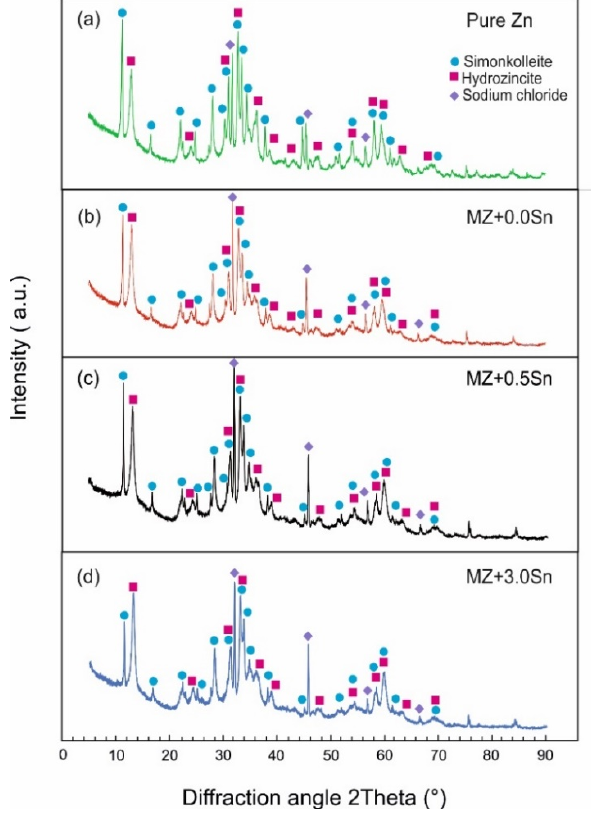
Figure 11. XRD patterns of corrosion product powders retrieved from the annealed samples after